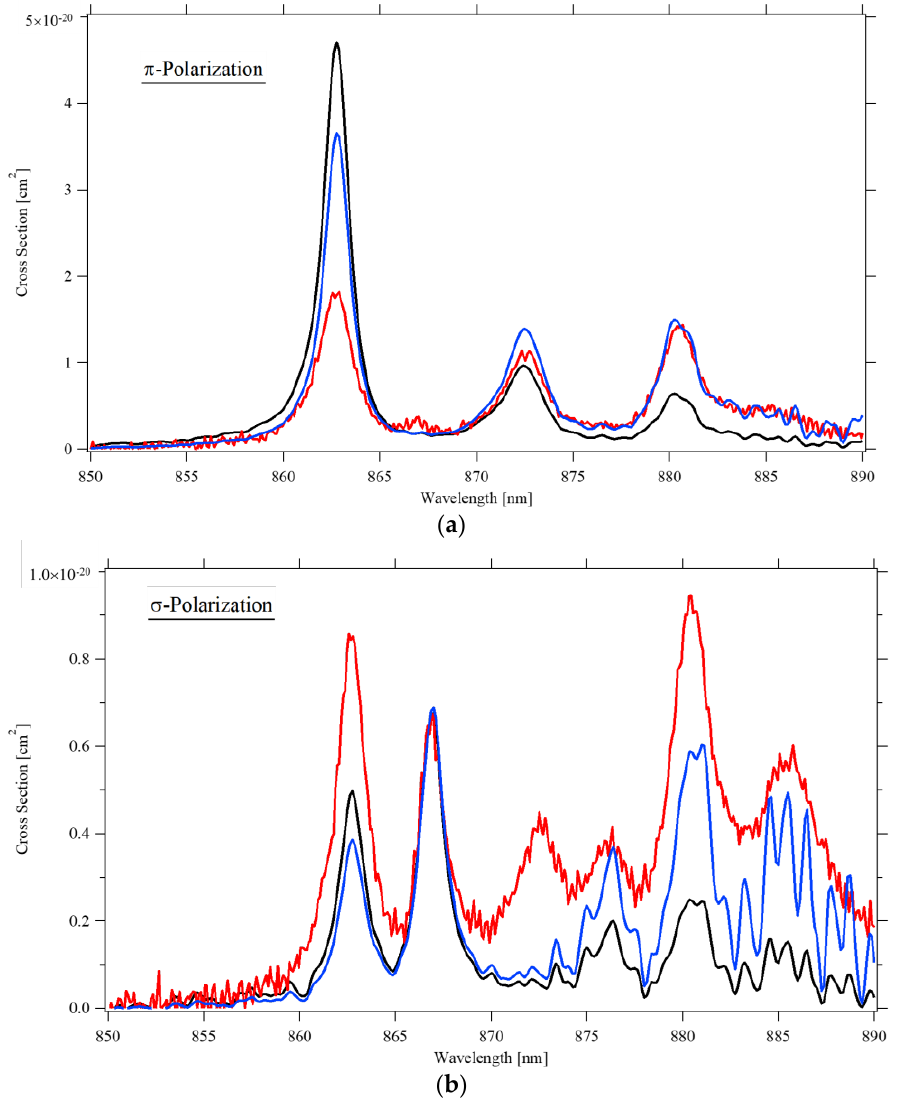
Figure 7. The absorption spectrum (black) and the emission spectra as obtained by Aull–Jenssen (red) and by reciprocity (blue) techniques, at 300 K: ( a ) π-polarization; ( b ) σ-polarization.